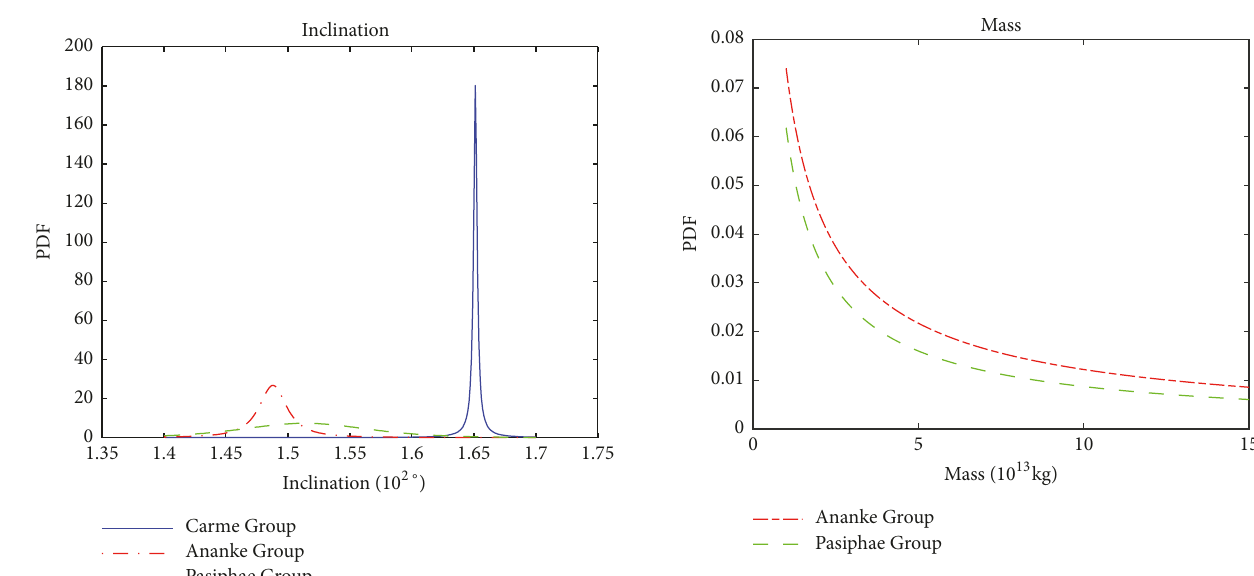
Figure 6: The PDF curves of